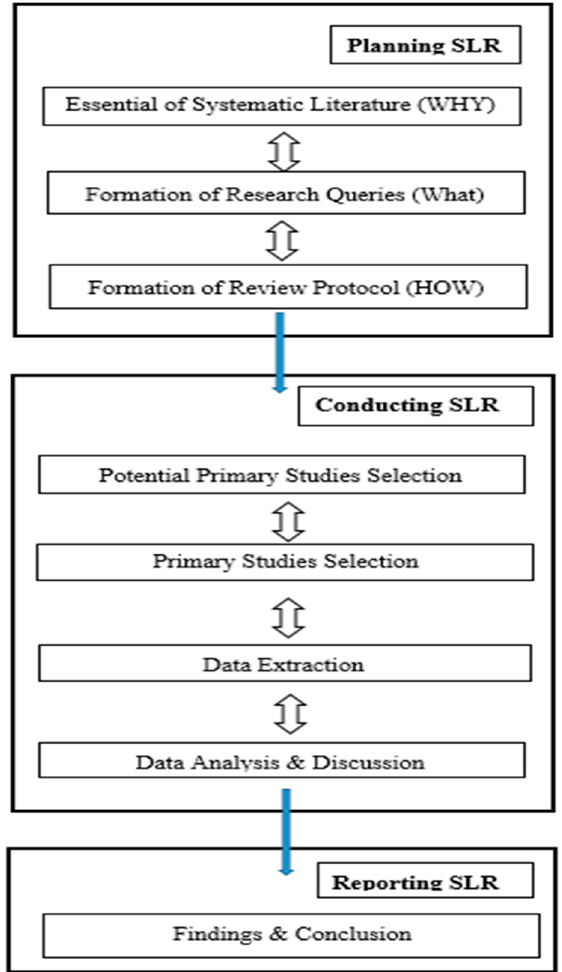
Figure 2. The systematic literature review process.